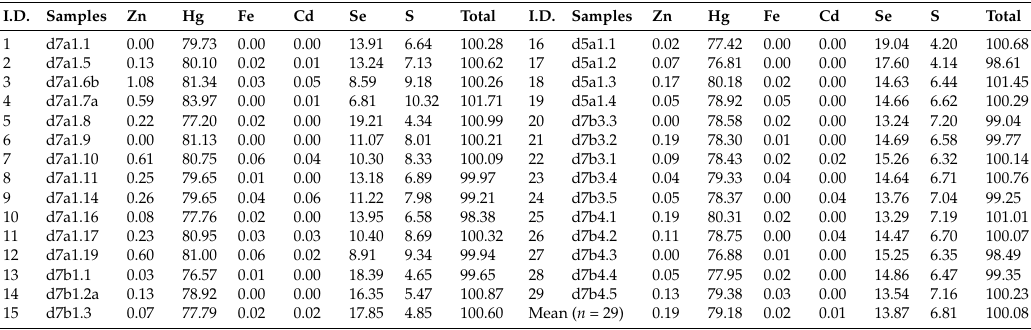
Figure 9. ( a ) Backscattered electron images; and ( b , c ) X-ray element-distribution maps for Zn and Hg, respectively, of Zn-bearing cinnabar (Zn-Cin) at the Chashula deposit. Table 3. EPMA data for selenium metacinnabar from the Dongping deposit (wt %). I.D. Samples